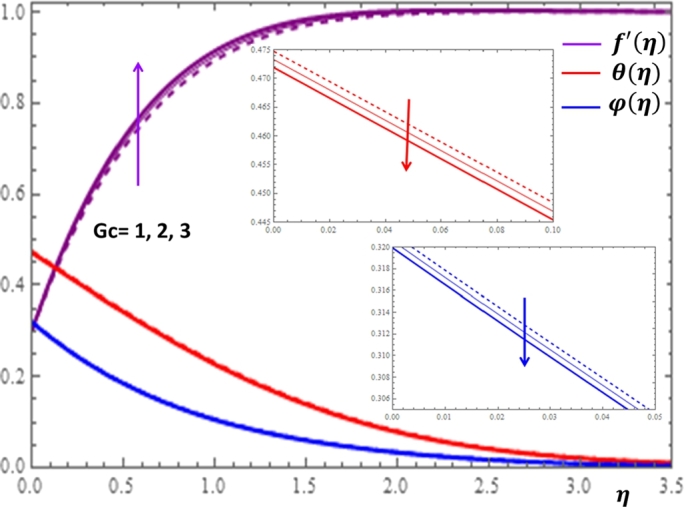
Impacts of concentration buoyancy parameter Gc on f′(η), θ(η) and φ(η).